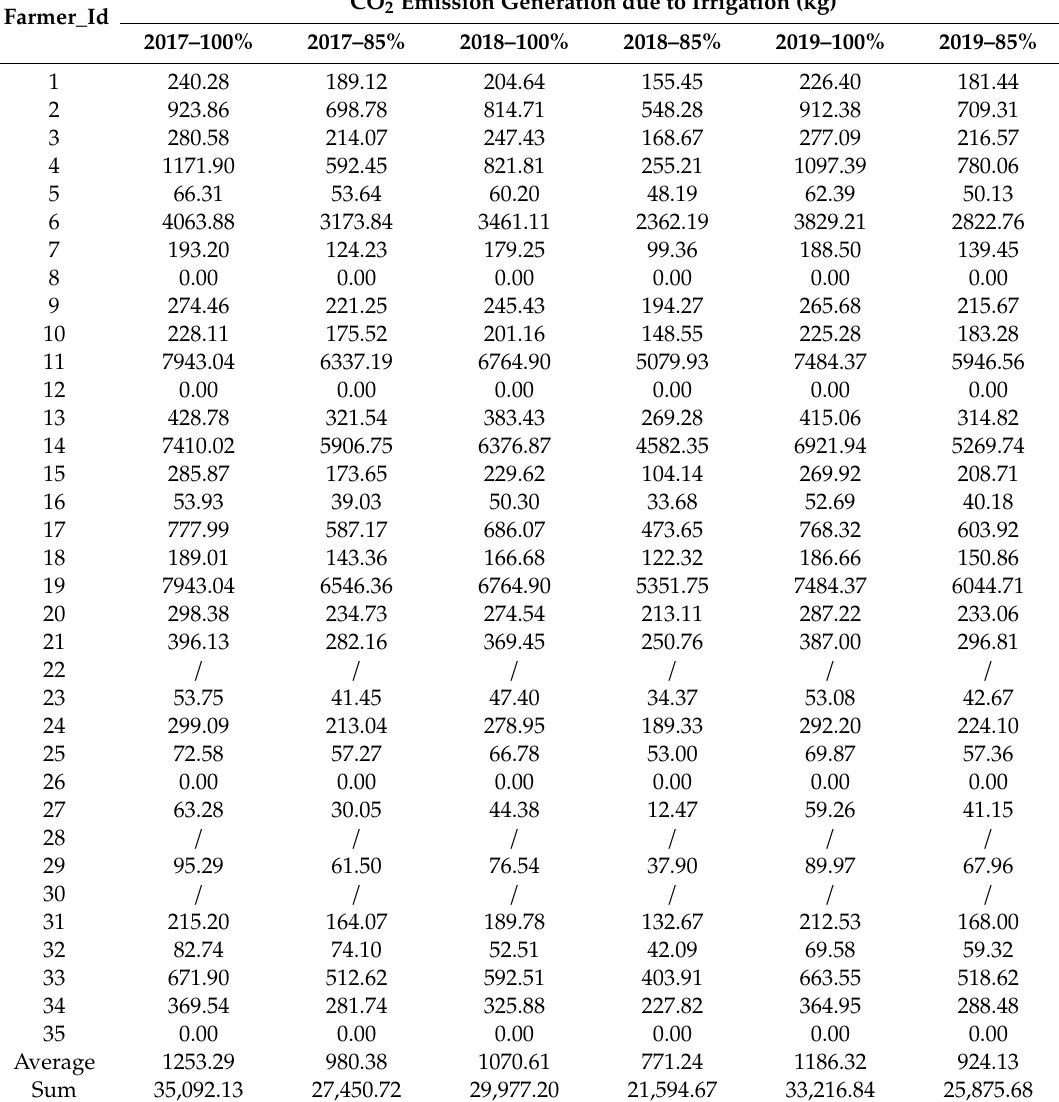
Table A11. Yearly CO 2 emission generation due to irrigation (kg) at farm level by replenishing soil water content to (i) FC and (ii) to 85% capacity